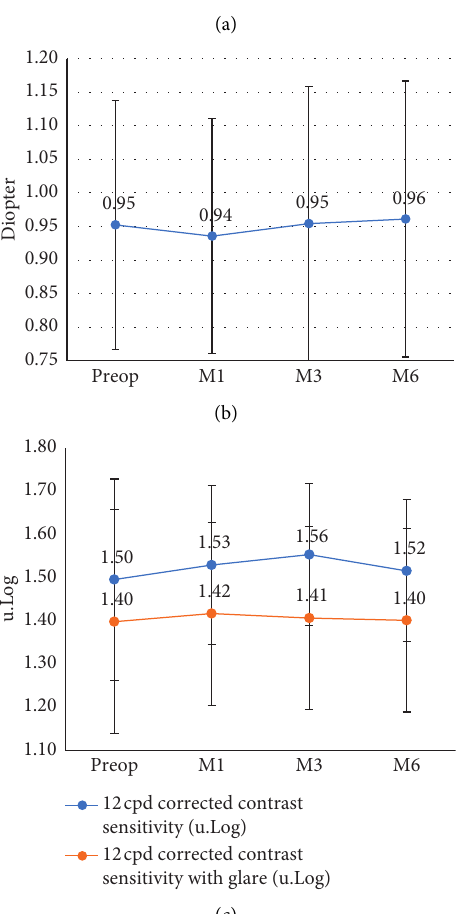
Figure 5: Evolution of visual outcomes after myopic LASIK. (a) Evolution of 90% and 10% contrast CDVA in the spectacle and the corneal planes. (b) Evolution of the corrected sensitivity to blur. (c) Evolution of 12cpd corrected contrast sensitivity and 12cpd corrected contrast sensitivity and 12cpd corrected contrast sensitivity with